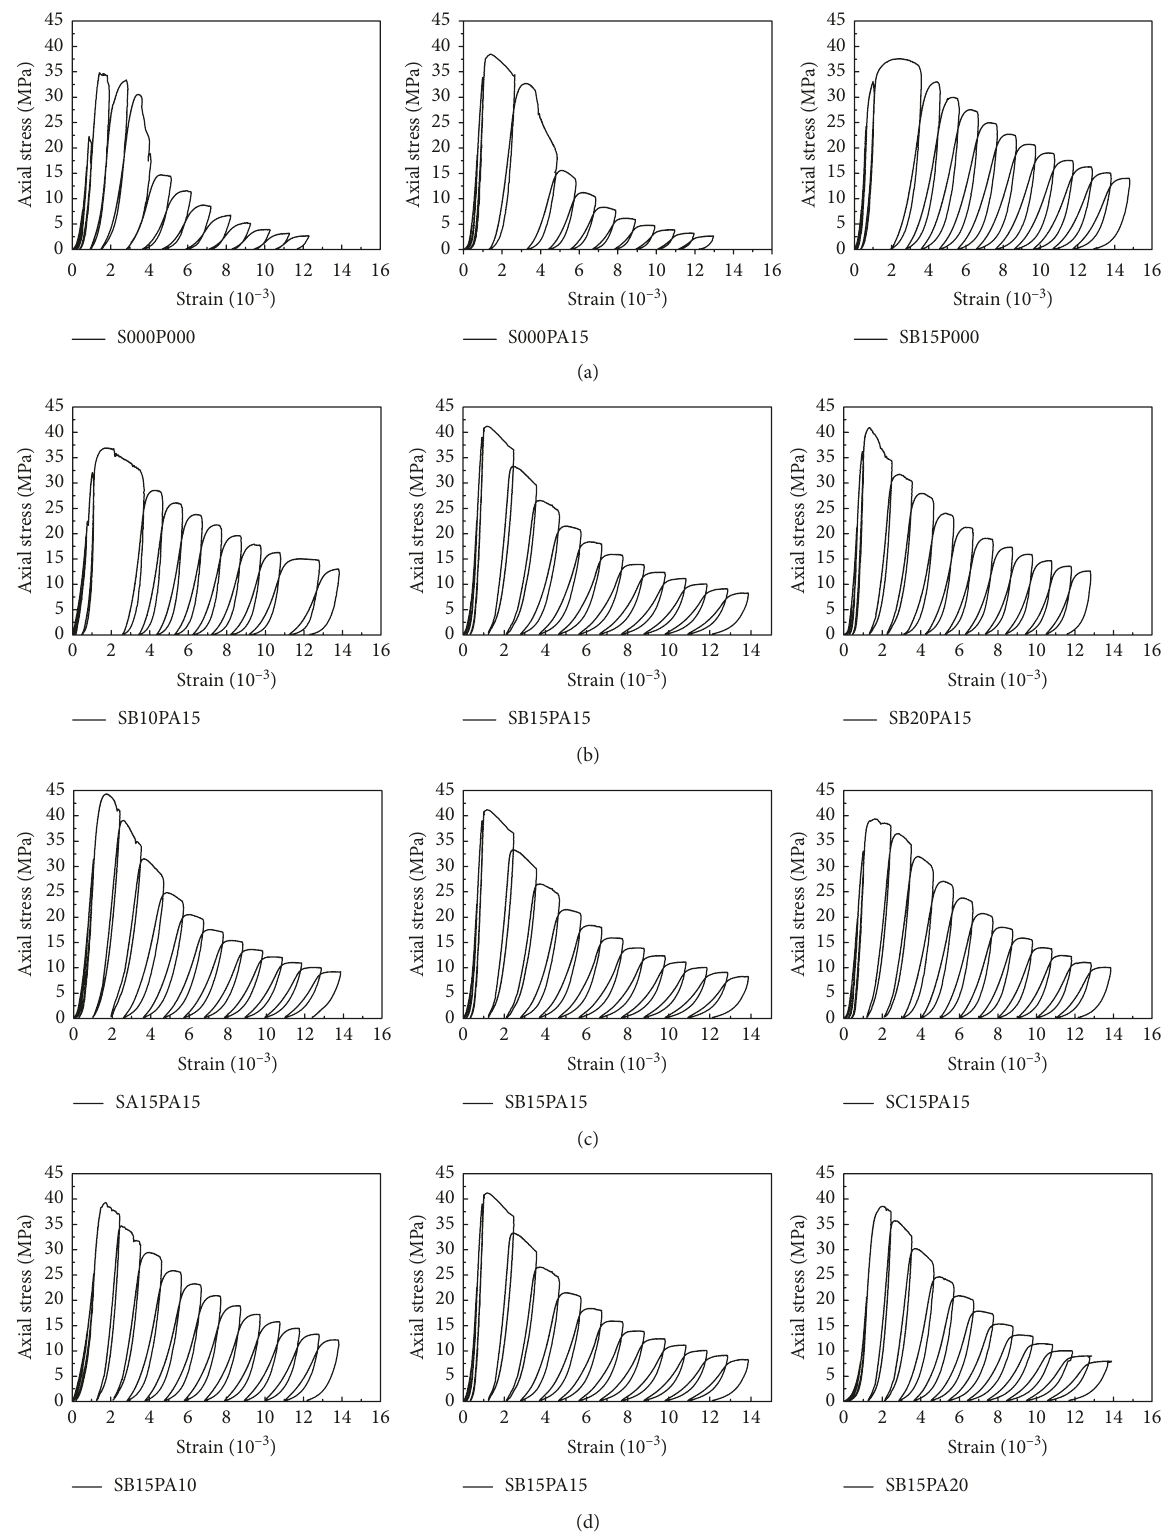
Figure 4: Cyclic stress-strain relations of the HFRC specimen: (a) effect of fiber type; (b) effect of volume fraction of SF; (c) effect of aspect ratio of SF; (d) effect of volume fraction of